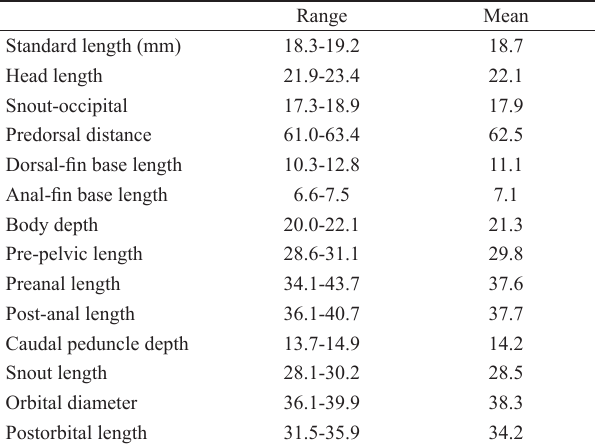
Table 1 . Morphometric data of males of Phallotorynus pankalos (n =